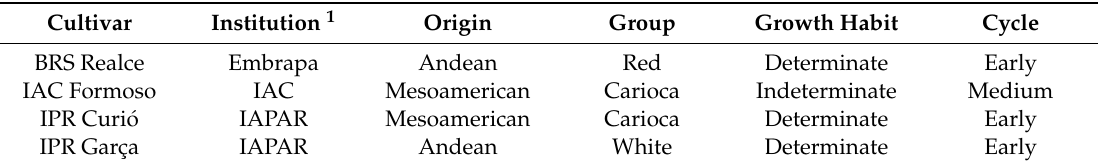
Table 1. Characteristics of common bean cultivars used in the test to determine the optimized Al